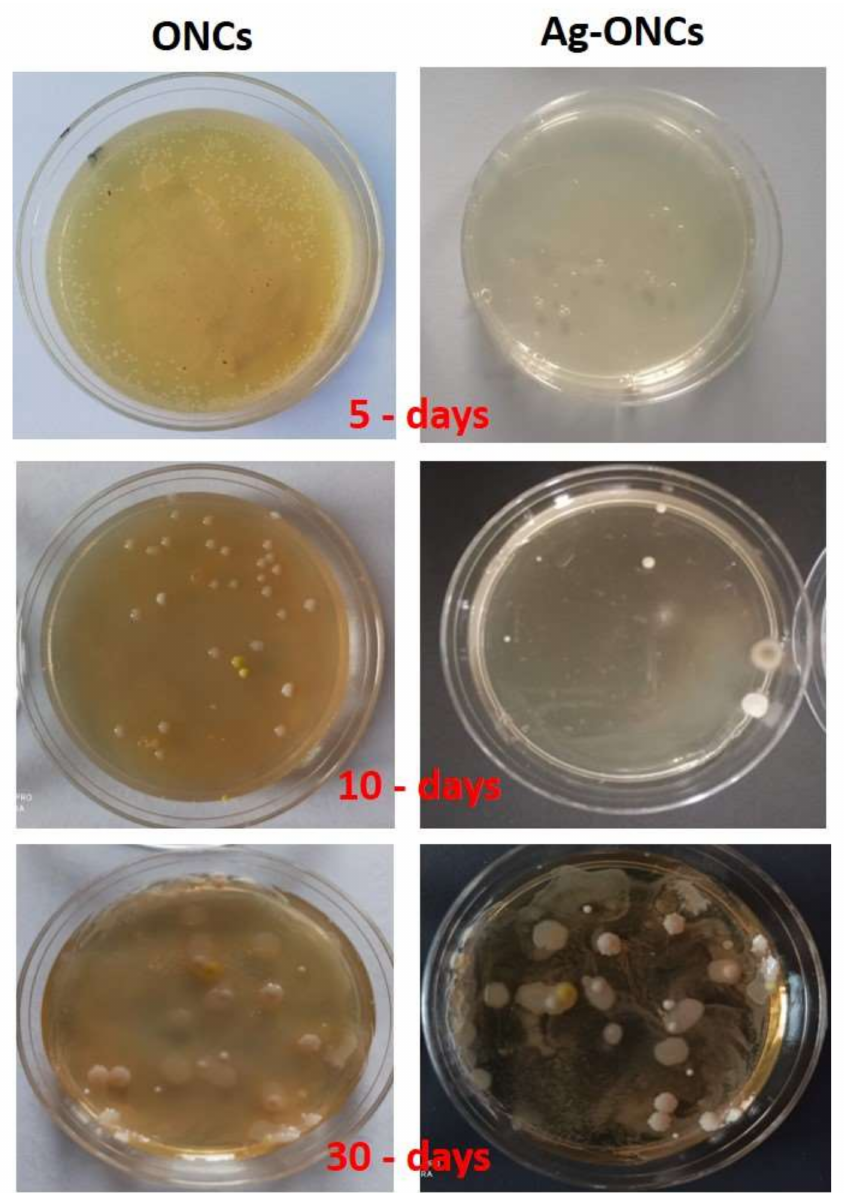
Figure 6. Comparison between ONCs and Ag–ONCs antibacterial properties after different incuba- tion times. Petri dishes are stored in the dark to avoid UV light